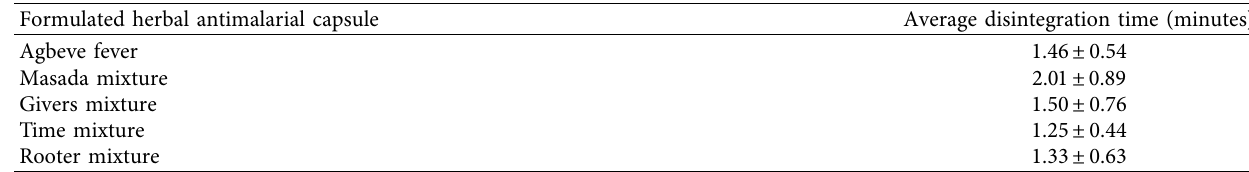
Table 5: Disintegration time of the herbal antimalarial capsules.